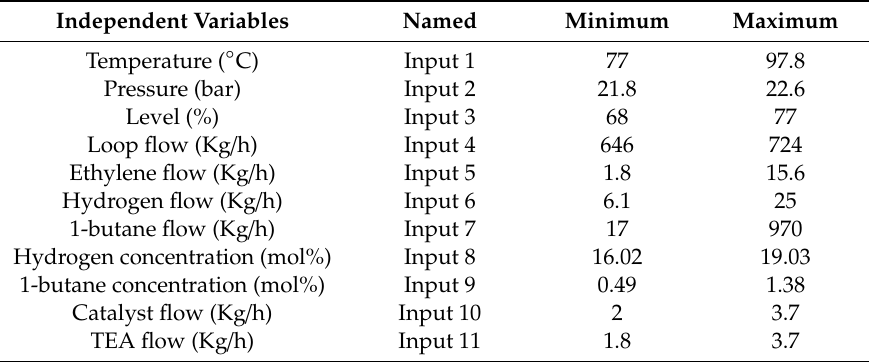
Table 1. Ranges and of the Industrial